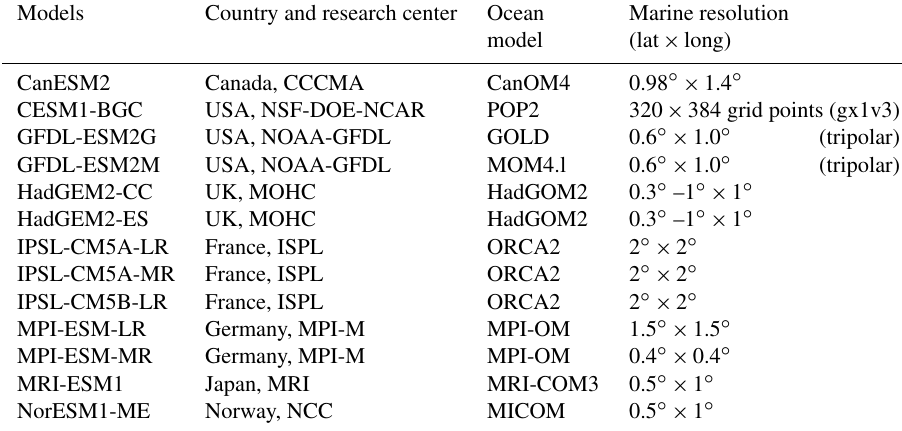
Table 1. CMIP5 models used in this study.